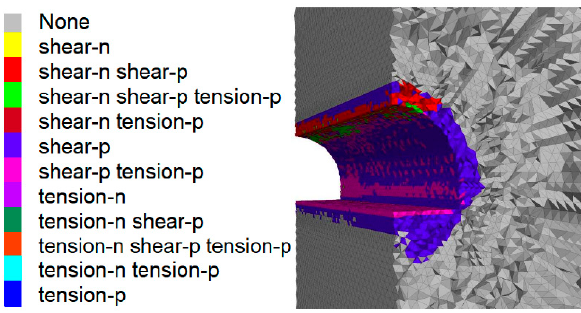
Figure 7. Plasticization zones in the homogeneous model (variant 0).